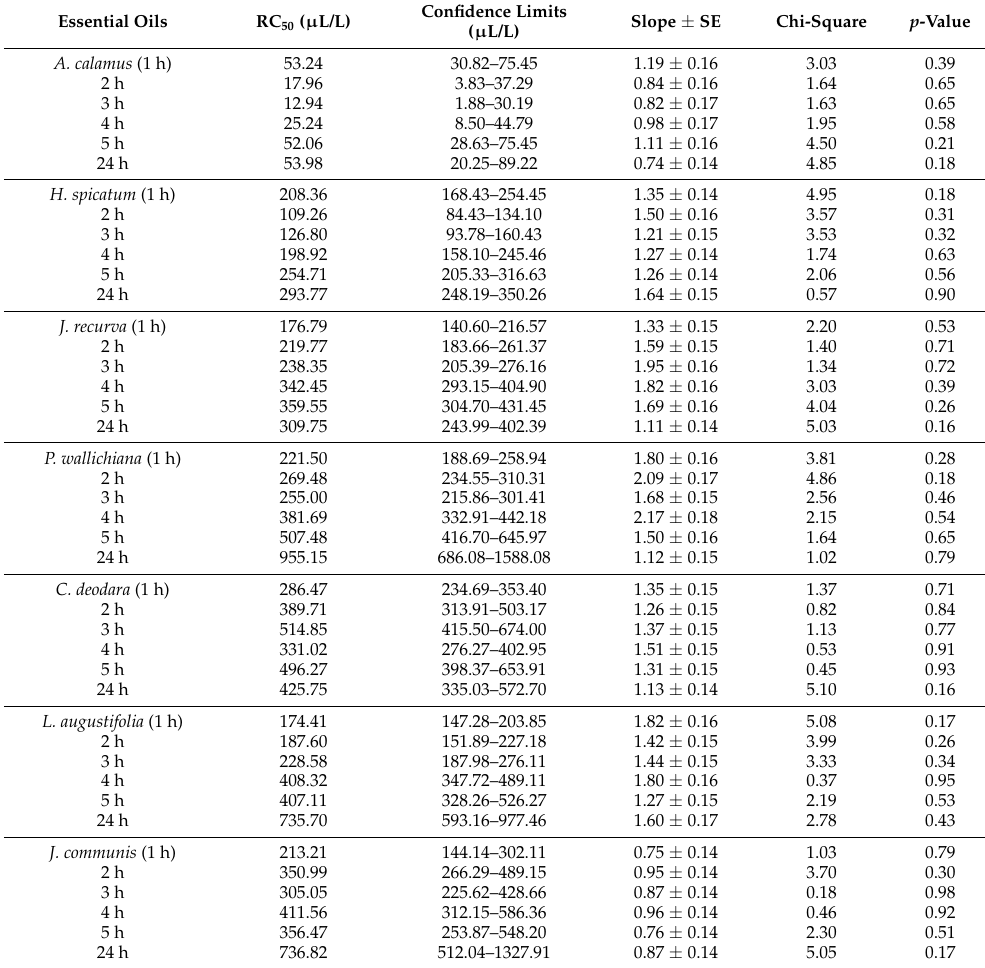
Table 4. Repellent activity of different essential oils against C. maculatus